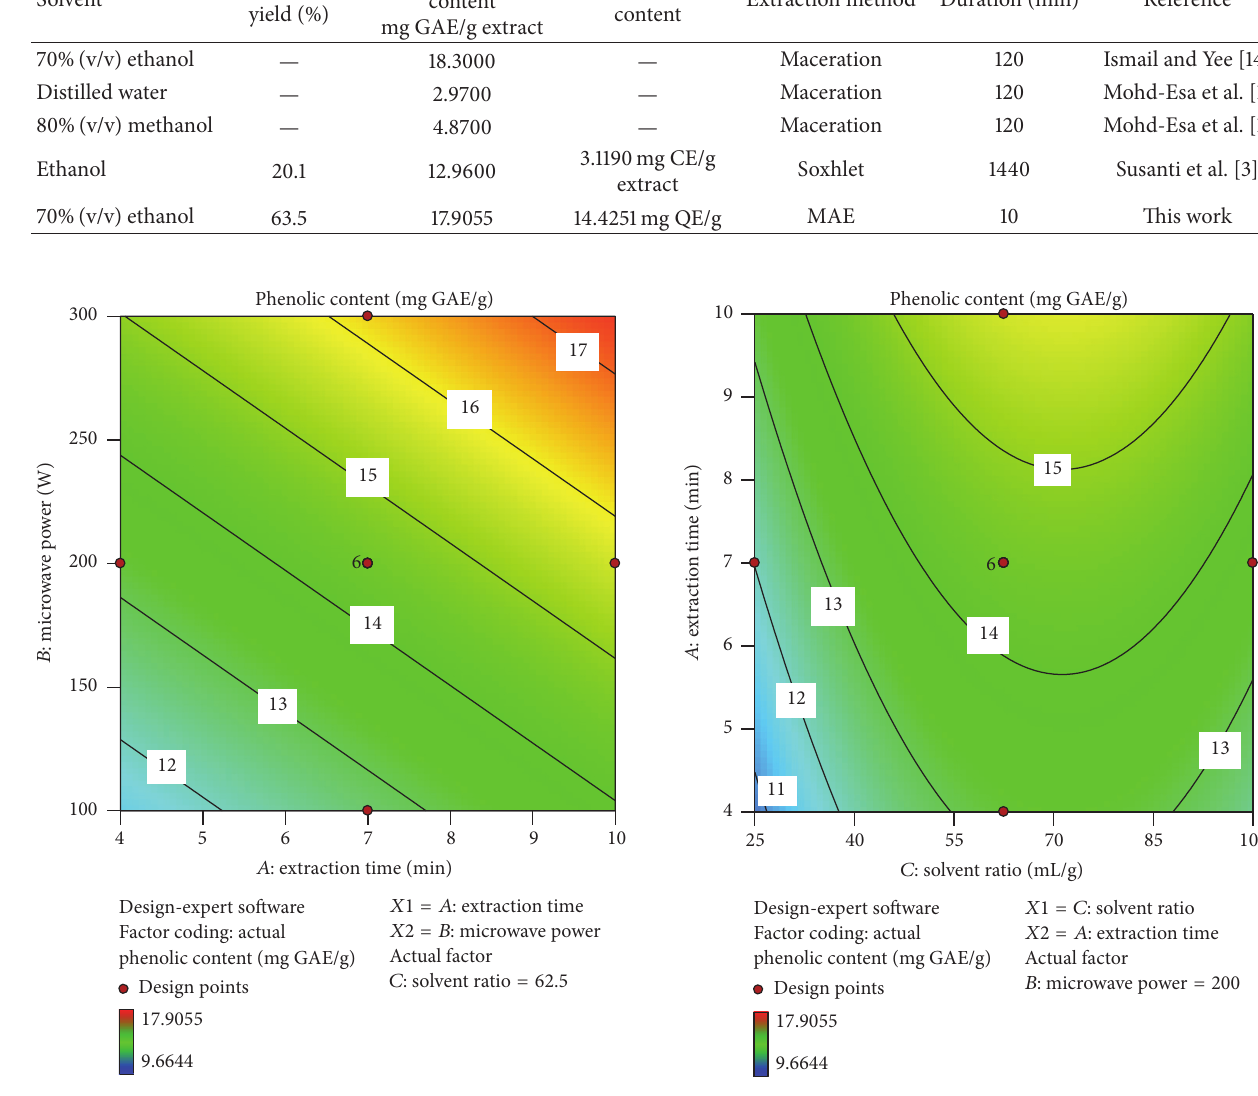
Figure 4: Response surface plot of the interaction between time ( 𝐴 ) and power ( 𝐵 ) on the total phenolic content of roselle seed.